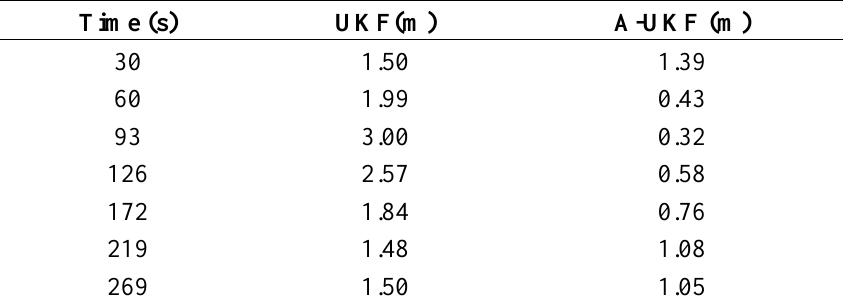
Table 6. Residuals of the gross-error